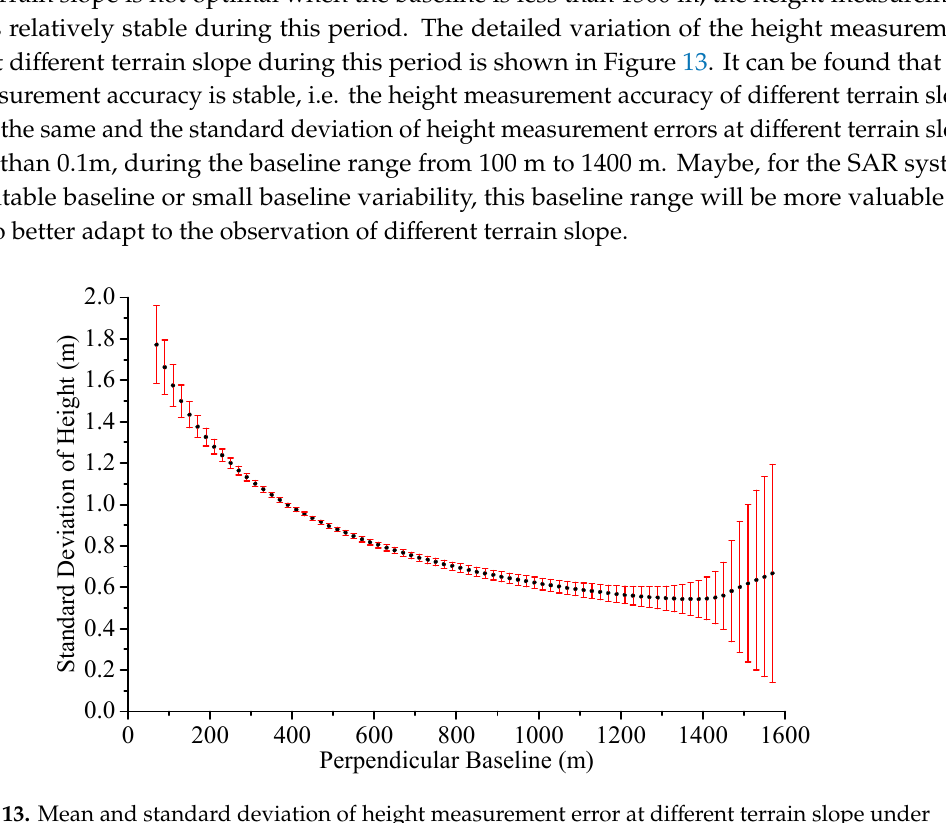
Table 3. Definition of the terrain types and optimal baseline range.